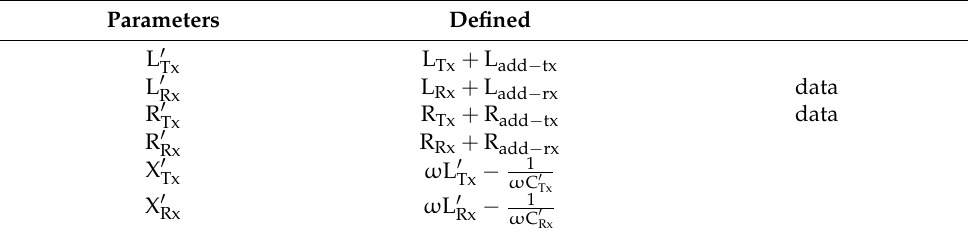
Table 1. Defined circuit constants taking into account the series inductors.